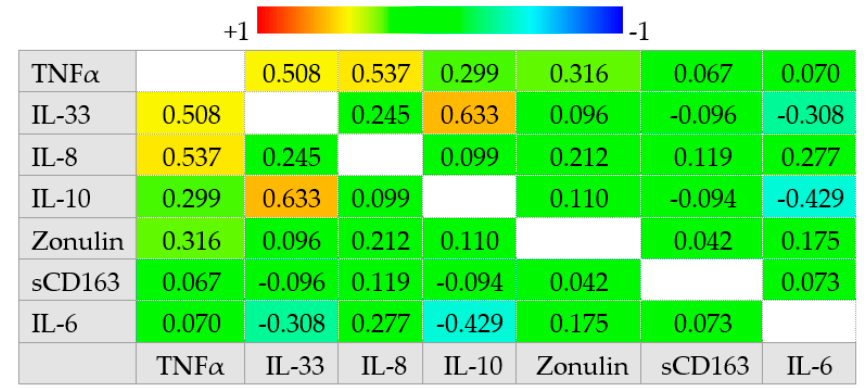
Figure 3. Correlogram reporting the Spearman correlation coefficient between serum zonulin, sCD163, and cytokine values in patients with IBD. Abbreviations: tumor necrosis factor-alpha (TNF α ).